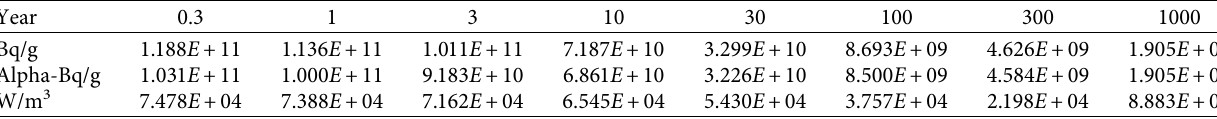
Table 10: Radiological characteristics of TRU/RE waste/waste form.